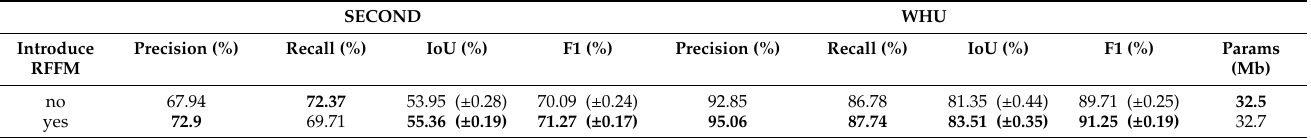
Figure 9. Visual comparisons of baseline without/with the RFFM. ( a ) Inference results on the SECOND dataset. ( b ) Inference results on the WHU dataset. For better visualization, we show the missing changes with red and unexpected changes with blue. Table 2. The ablation study of applying the RFFM to the baseline. The symbol ± means the perfor- mance fluctuation. The values in bold font are the